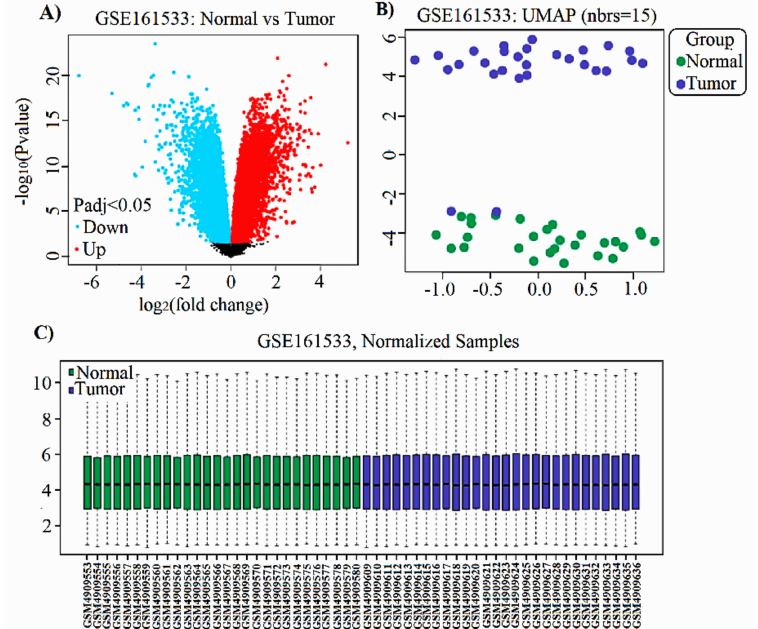
Figure 1. Dataset GSE161533 samples validation. ( A ) Volcano plot using limma for the normal and tumor samples shows the up and downregulated genes. ( B ) UMAP test to predict the samples clearer separation. ( C ) Boxplot of normalized expression values for the dataset GSE161533. The dots represent the median of each sample in the center of each box. Its variation among samples reflects the amount of data normalized, with a relatively straight line suggesting a reasonable level of normalization. Module preservation test with an independent